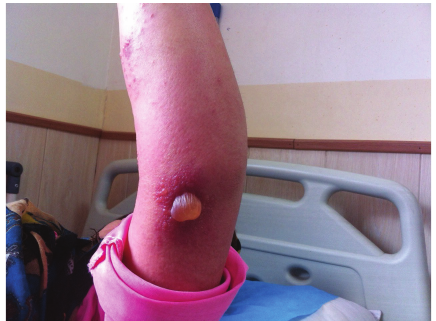
Figure 4: Vesiculobullous lesions on her left elbow.